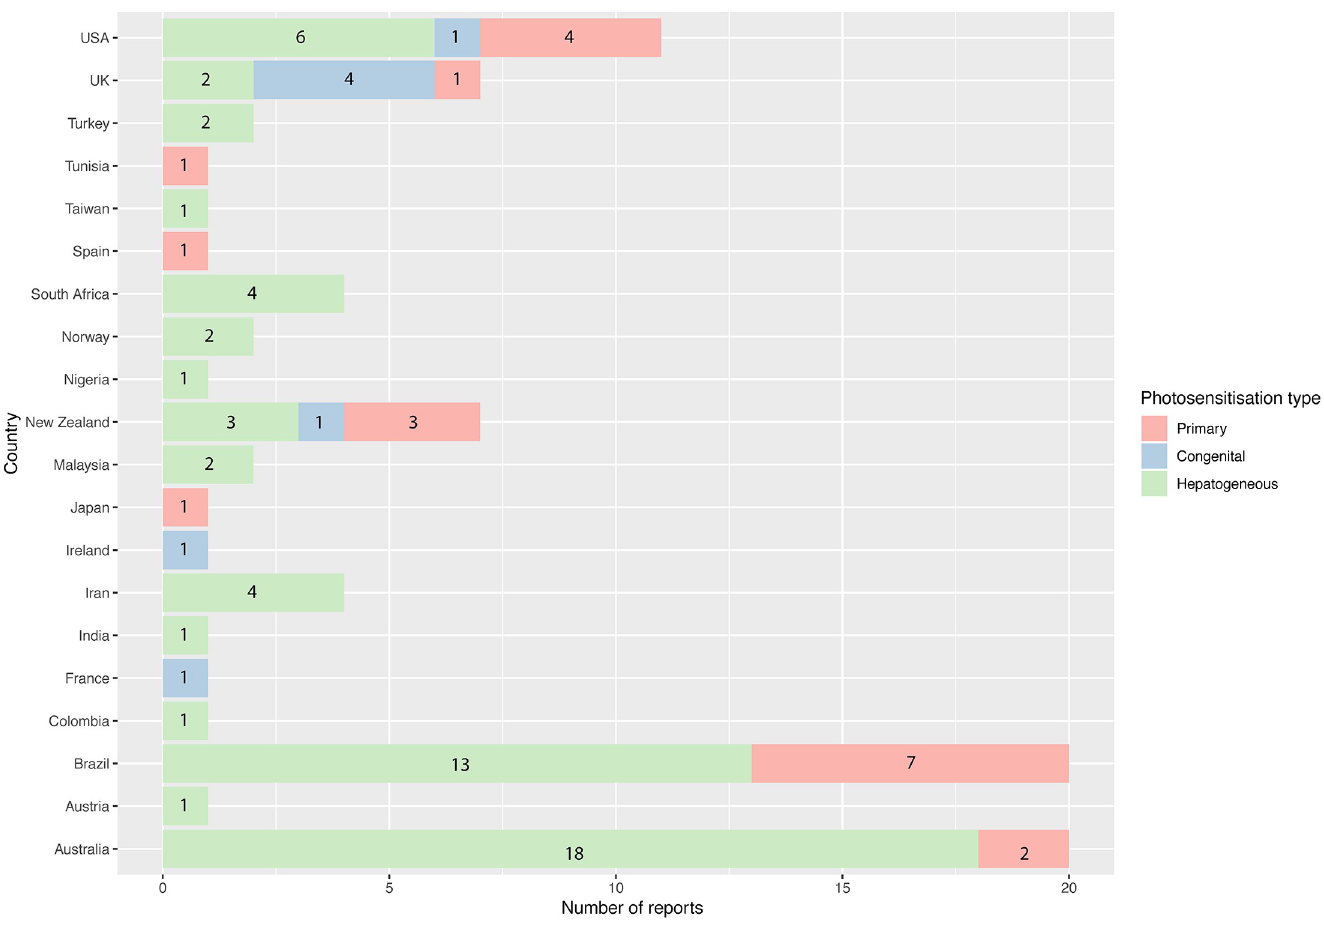
Fig 4. Numbers of peer-reviewed case reports by country by type of photosensitisation: Primary, congenital or hepatogenous.